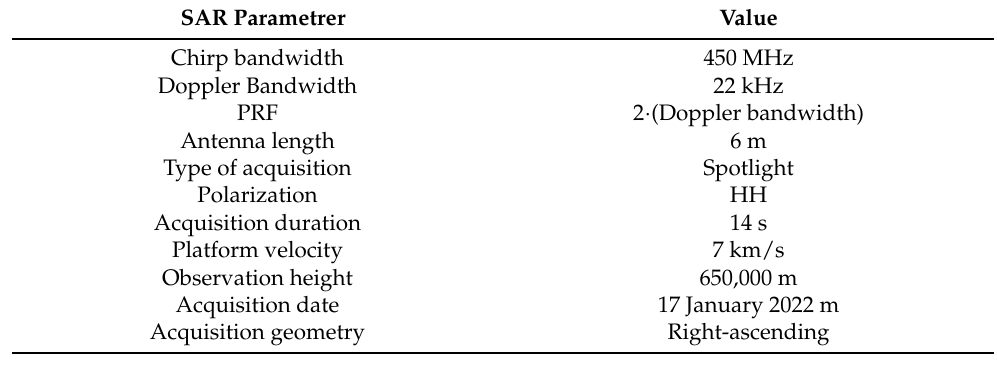
Table 1. Characteristics of the SAR acquisitions.